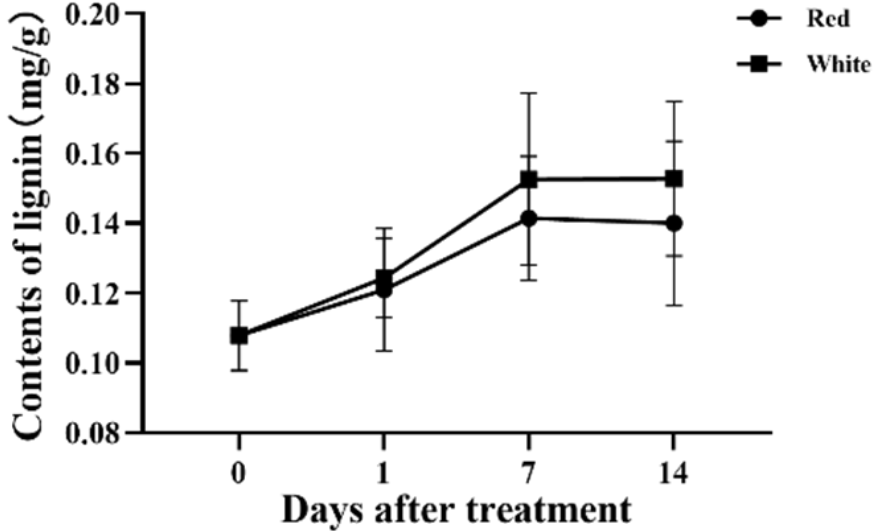
Figure 10. Lignin content in the stem of P. yunnanensis on days 1, 7, and 14 under light irradiation. The abscissa represents the days of treatment, and the ordinate represents the content of lignin.